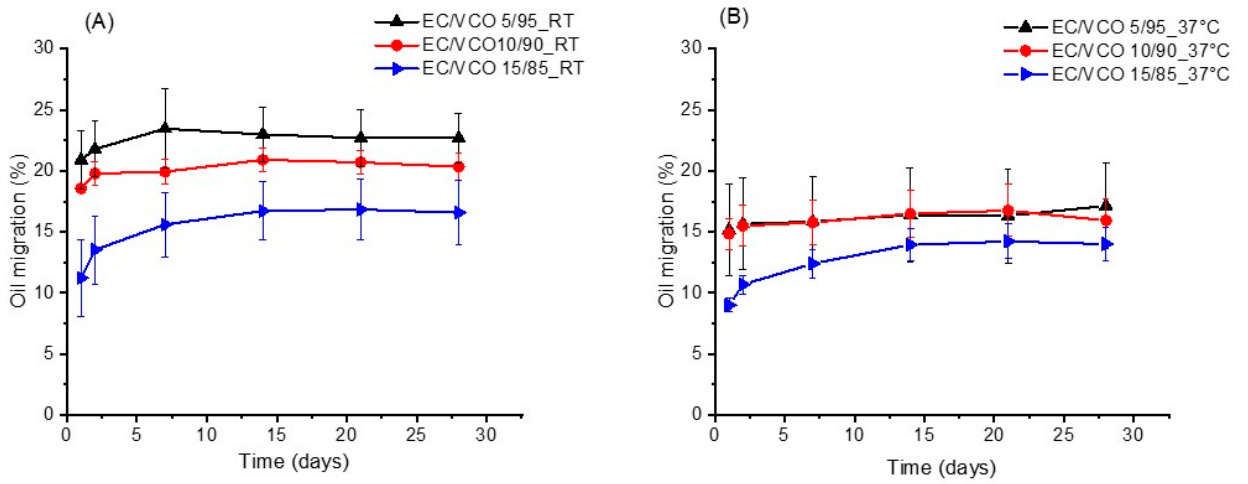
Figure 4. Oil migration from the EC/VCO oleogels to the filter paper for 28 days. Temperature conditions: ( A ) room temperature and ( B ) 37 °C.